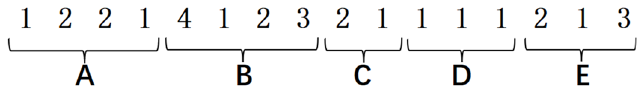
Figure 2. Schematic diagram of chromosomal genes.